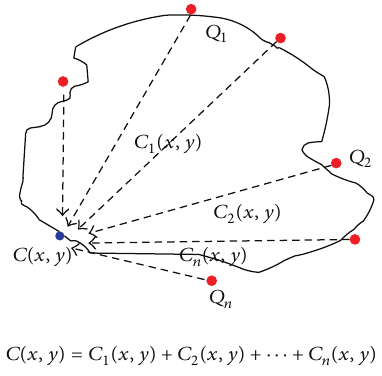
Figure 1: Stacking chart of concentration